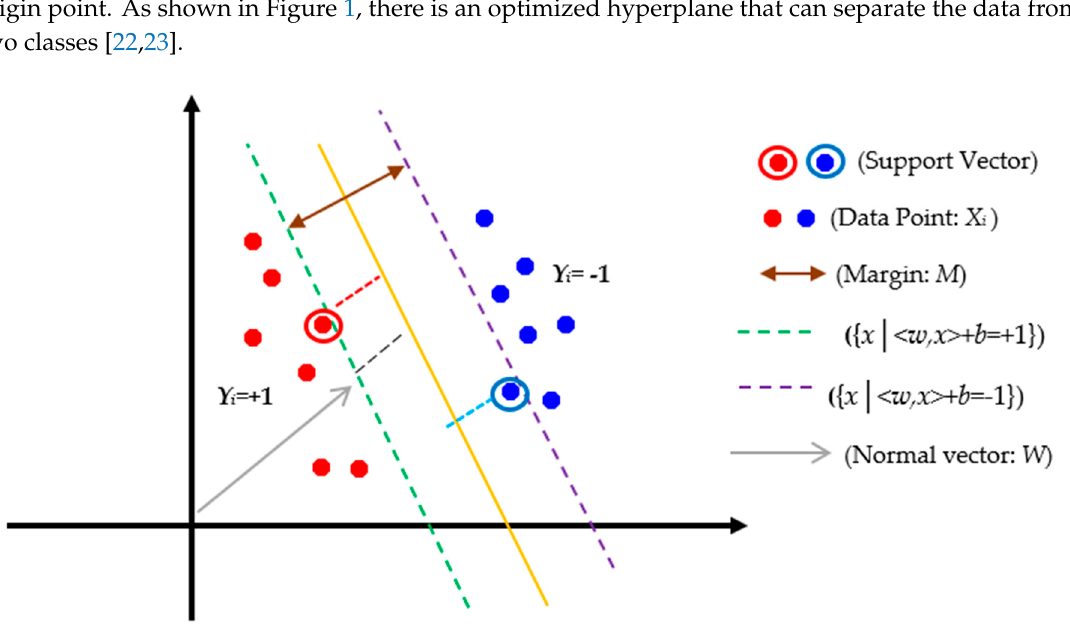
Figure 1. Optimized hyperplane for two-dimensional space (Linear-SVM) [23]. SVM: support vector machine.